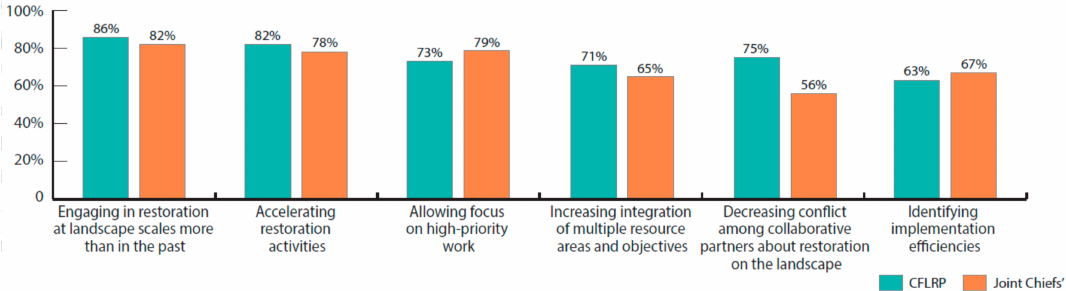
Figure 1. Percent of respondents who agreed or strongly agreed that the Collaborative Forest Landscape Restoration Program (CFLRP) or Joint Chiefs’ helped them achieve accomplishments in different areas. Note: The items in the figures were the ones selected by the most participants and do not include all items included in the respective sections of the questionnaire.